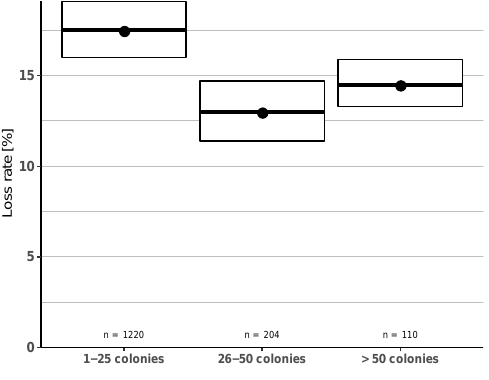
Figure 8. Categorized operation size groups and their winter honey bee colony loss rates (and 95% CI): The number of reported colonies before the onset of winter (2018) were used for the